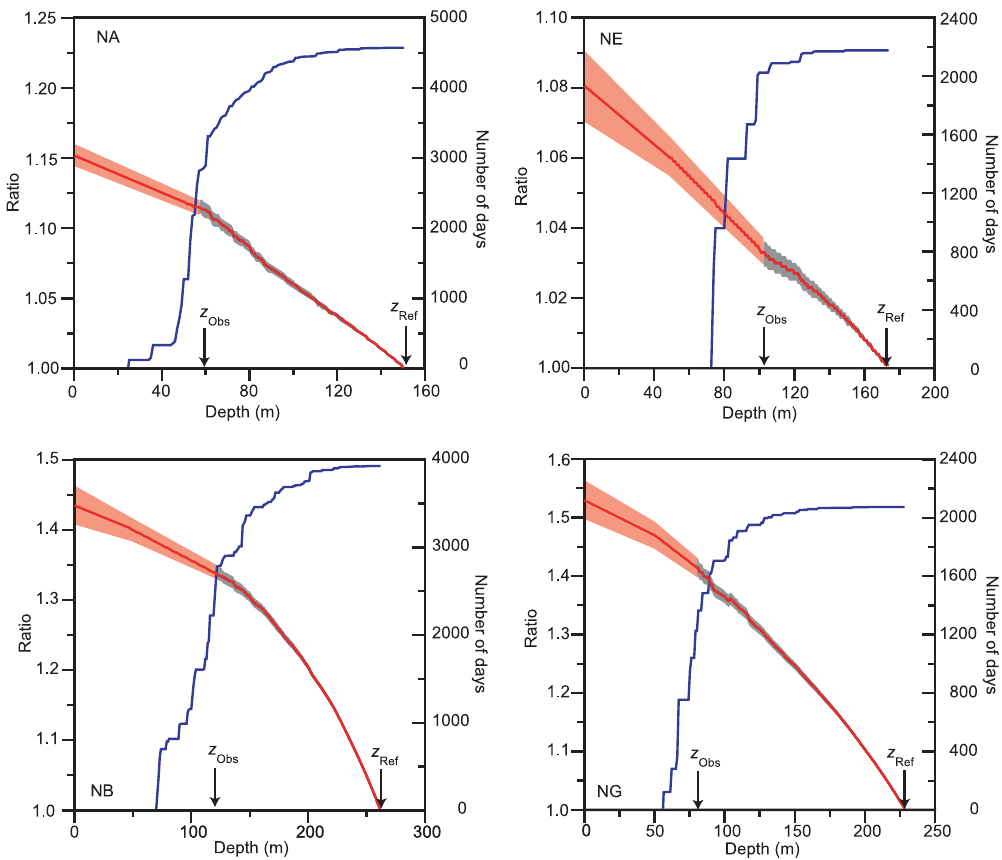
Figure 2. Vertical variation of eastward velocity for the long-term ADCP sites. Each panel shows for one of the long-term ADCP sites, the number of days with data at each depth (blue curve, right scale) and the ratio U(z,t)/U(z Ref ,t) (red curve, left scale). Here, U(z,t) is eastward velocity at depth z for time t and z Ref is the depth, up to which all profiles from the site are complete. Profiles with | U(z Ref ,t) | < 10cms − 1 are excluded. From z Ref up to the depth z Obs , the ratio represented by the red curve is the average ratio based on observed ADCP profiles and the shaded gray area is ± one standard error. Above z Obs , graphical extrapolation is applied up to 50m depth. From there to the surface, the red curve is based on average geostrophic profiles. The shaded red area is graphically extrapolated from the gray area and indicates